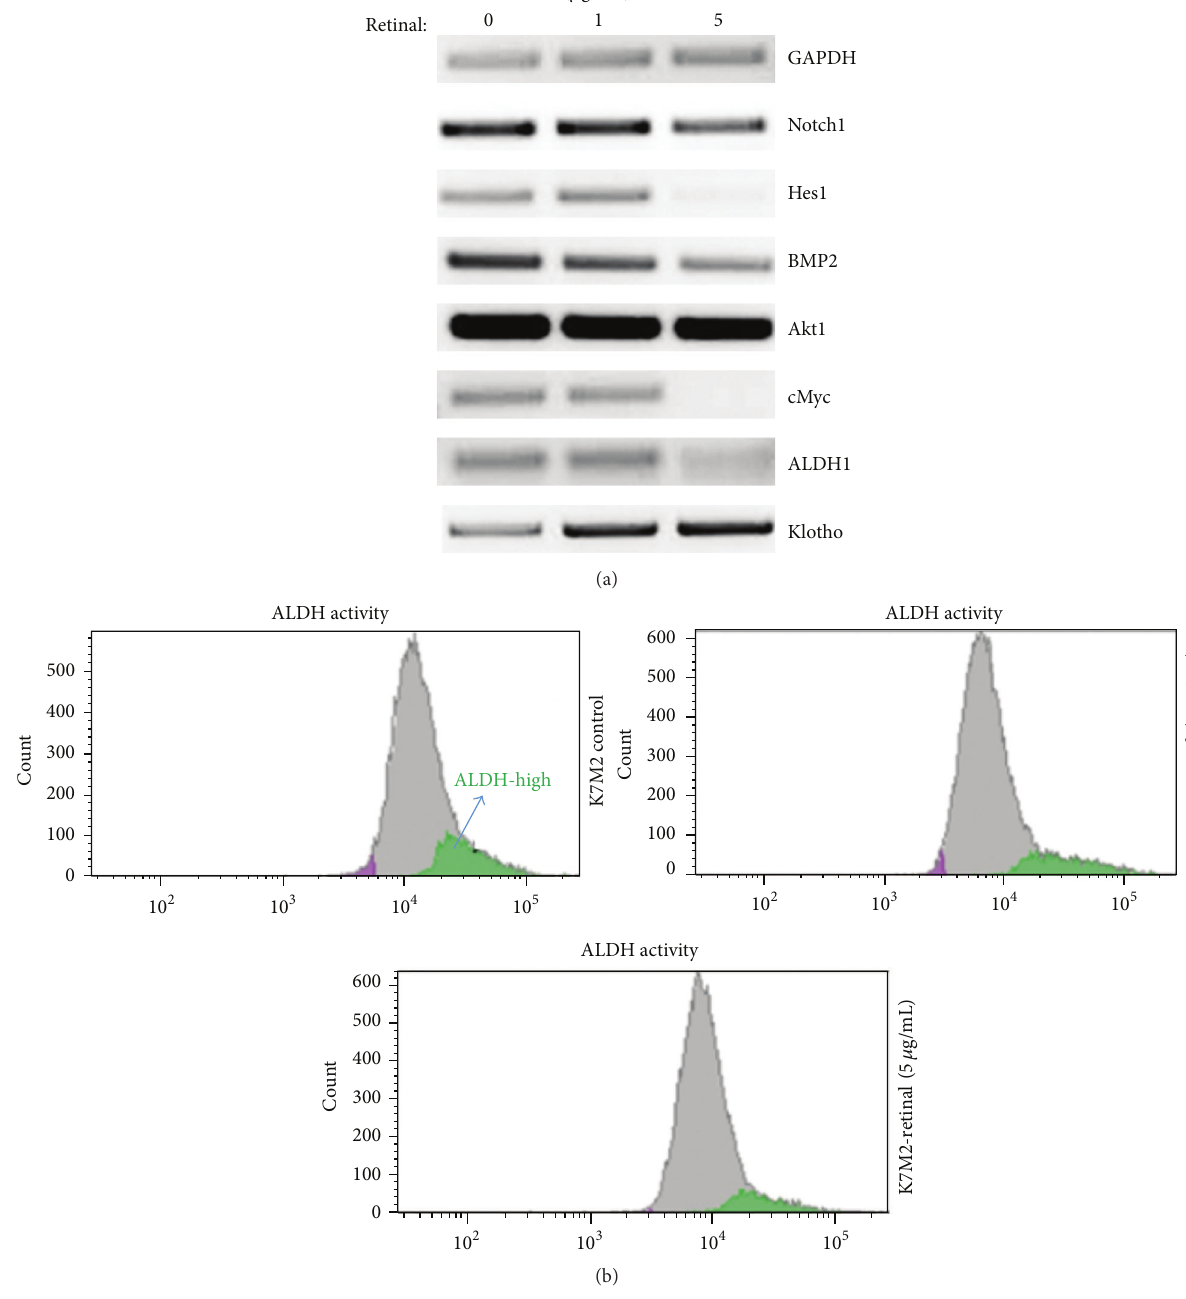
Figure 3: Retinal treatment of K7M2 cells modified the expression of metastasis-related genes and reduced ALDH activity. (a) RT-PCR results showed retinal treatment of K7M2 cells (1 or 5 𝜇 g/mL for 2 days) modified the expression of some key genes related with metastasis or tumorigenesis. (b) ALDH activity assay showed that retinal treatment of K7M2 cells reduced the aLDH activity of the cells.